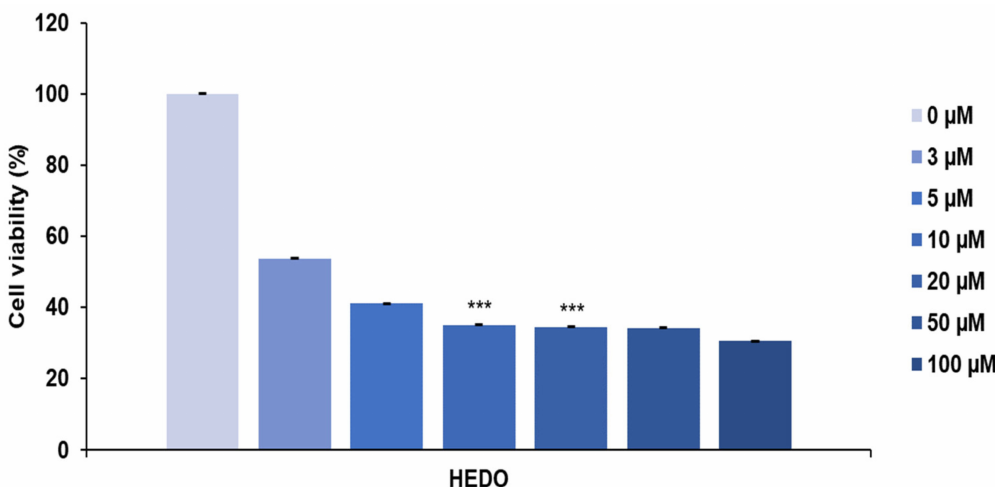
Figure 2. Anti-proliferative e ff ects of Inula britannica HEDO on OCI-LY3 cells. Cell viability was assessed by the MTS assay at 48 h after treatment. Values indicate the means ± SEM. (n = 3, *** p ≤